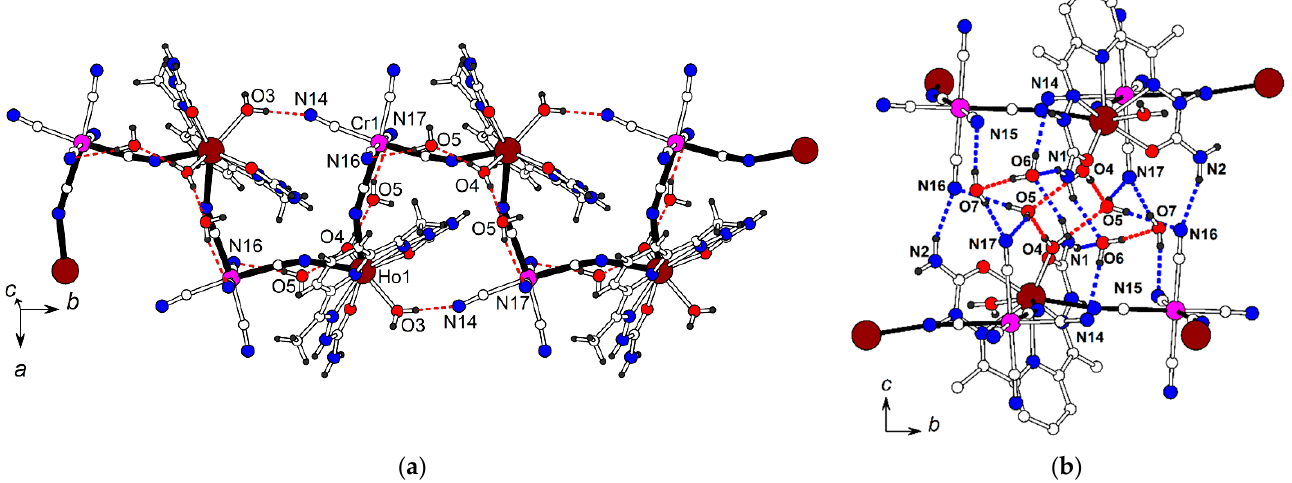
Figure 3. ( a ) Infinite square-wave chain in 3 . Chain-defining bonds are shown by black solid lines, hydrogen bonds—by red dashed lines. ( b ) Fragments of two adjacent chains with interchain hydrogen bonding (see Tables S2–S5 for hydrogen bond geometry).